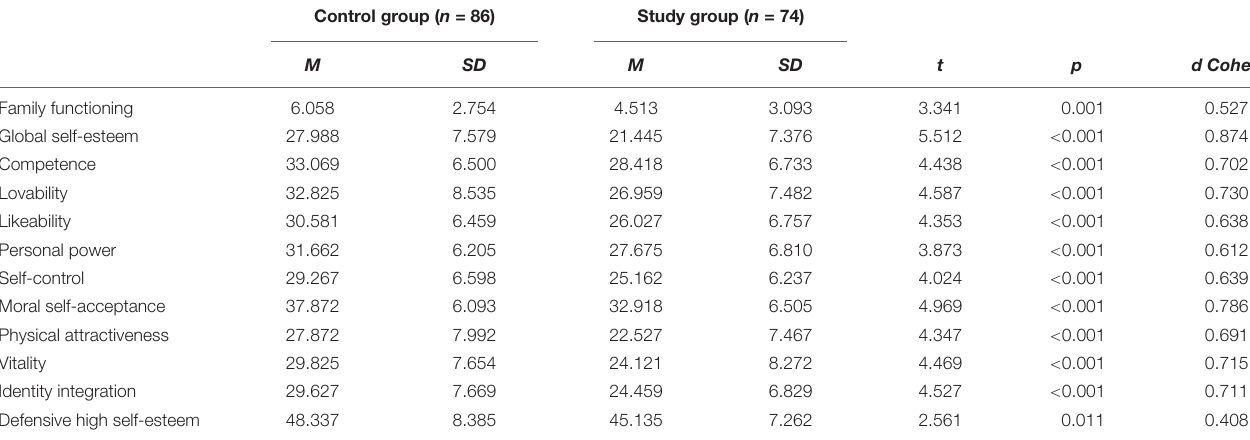
FIGURE 1 | Theoretical model of the role of the mediator in the relationship between family functioning and eating disorders. ∗ p < 0.05; ∗∗ p < 0.01.